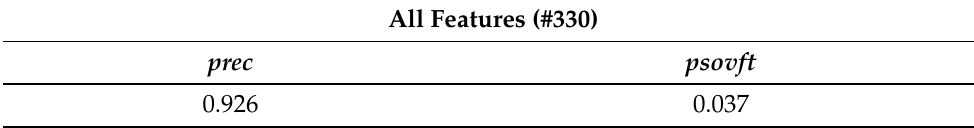
Table 4. Results achieved by the classifier when training with the original feature subset.